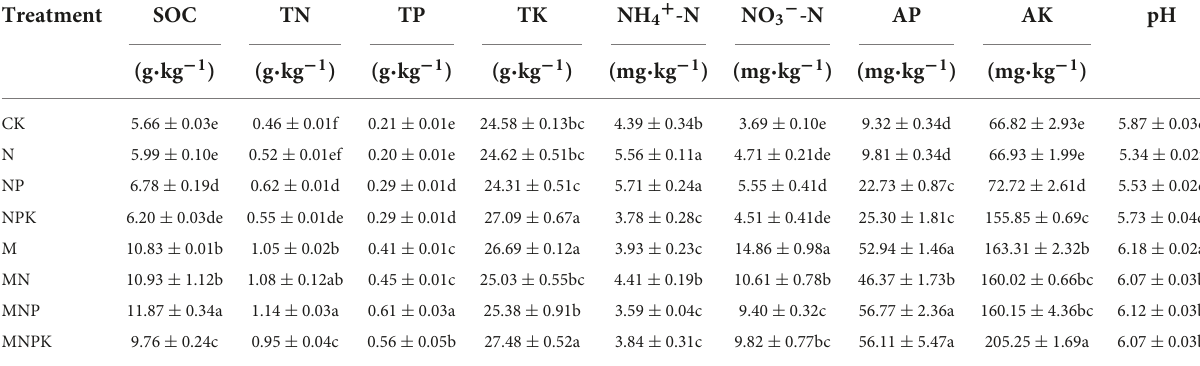
TABLE 1 Soil properties for different fertilizer treatments.